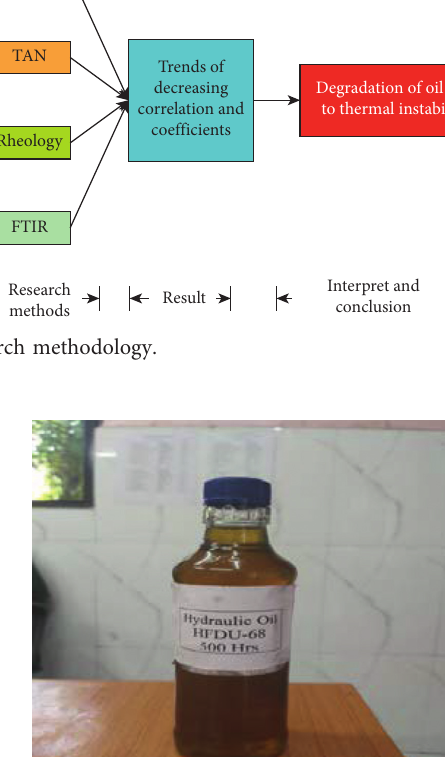
Figure 7: 500-hour used oil sample.